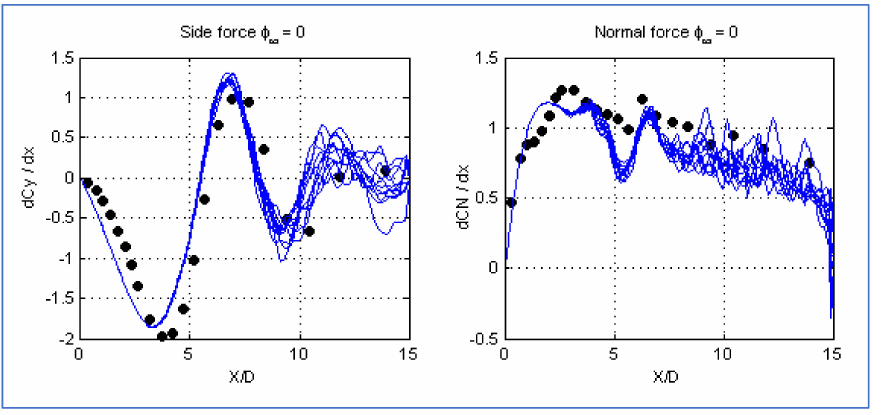
Figure 10. Several local side and normal force coefficients at Mach number Ma = 0.2, Reynolds number Re = 2 × 10 6 and angle of attack α = 45 degrees taken within a period of T = 0.1 s in intervals of ∆ t = 0.005 s. Grid S1. ω -based RSM-SAS model solutions and experimental data (black